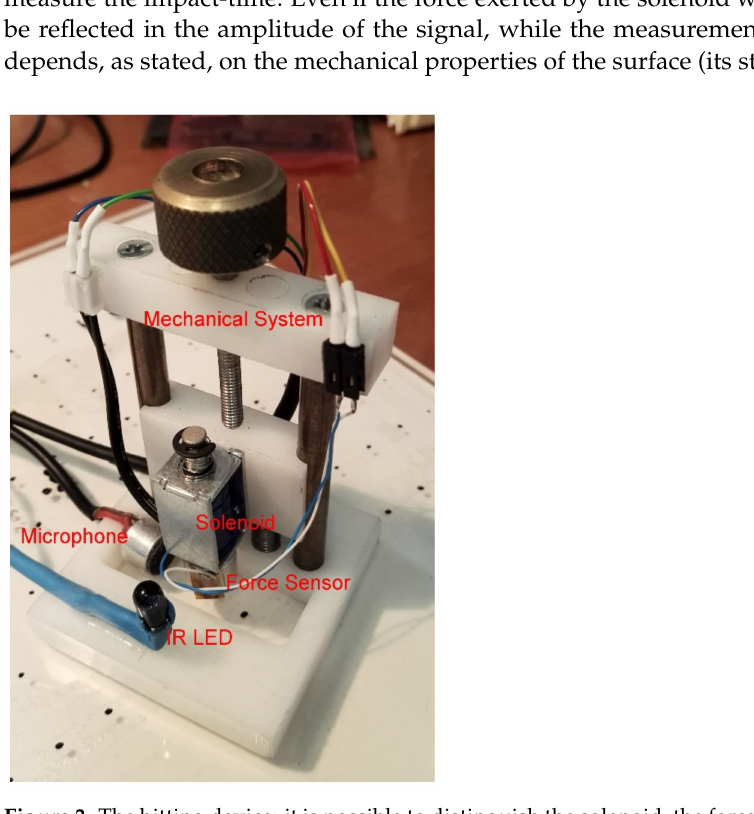
Figure 3. The hitting device: it is possible to distinguish the solenoid, the force sensor, the microphone and the infrared (IR) light-emitting diode (LED) used for positioning the device. In the background, the simple mechanical system that allows the device to be calibrated while changing the surfaces to be